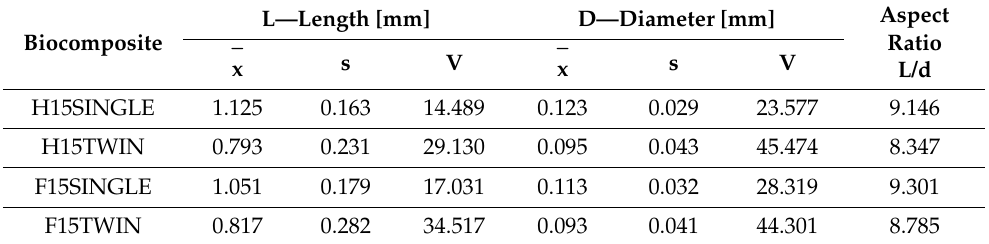
Figure 12. The photographs of fibers on the surface layer of PHBV biocomposite samples (magn. 50×): ( a ) H15SINGLE, ( b ) H15TWIN, ( c ) F15SINGLE, ( d ) F15TWIN. Table 9. The results of fiber geometry measured on the top layer of the sample.